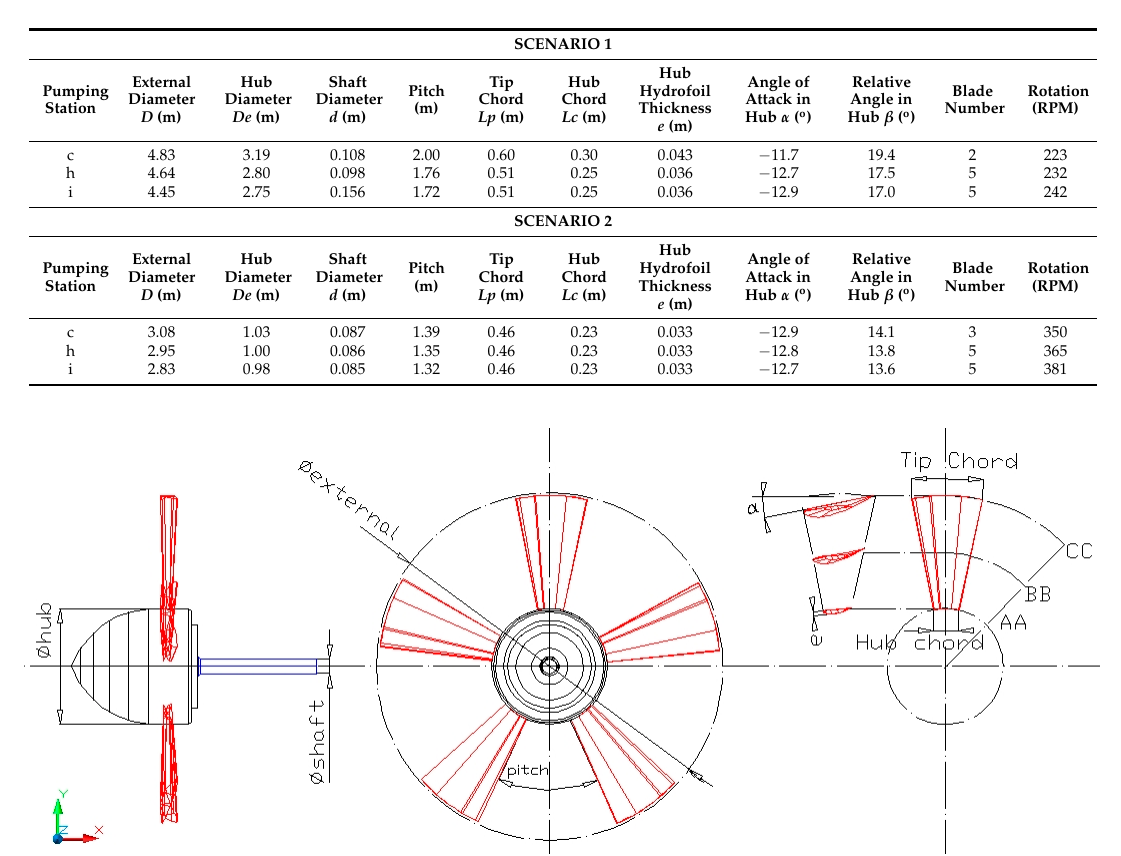
Figure 15. Rotor dimensions of the axial pump.